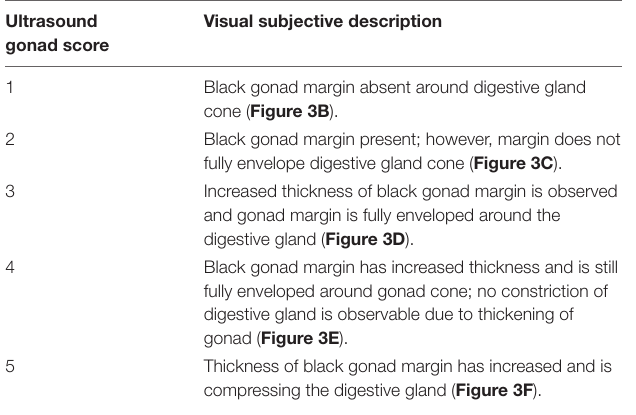
Ultrasound gonad score